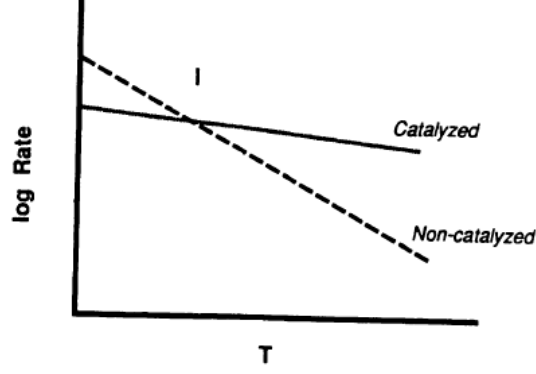
Figure 4. Arrhenius plots of catalyzed and non catalyzed gasification showing an isokinetic point I.